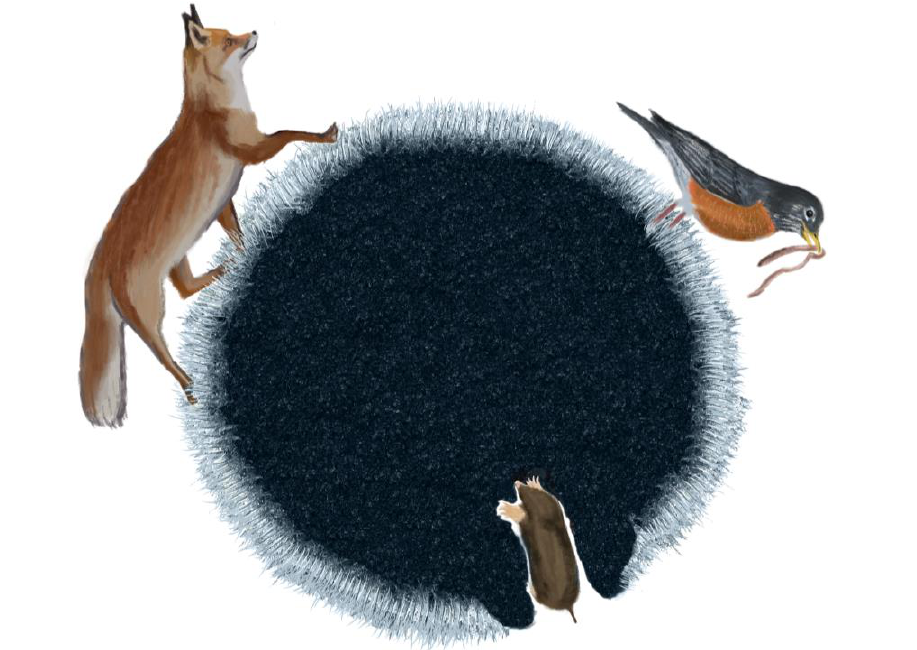
Affordances: The Surface of a Loamy Soil Affords Tunneling to a Mole, Probing in Search of Prey to a Bird, and Walking to a